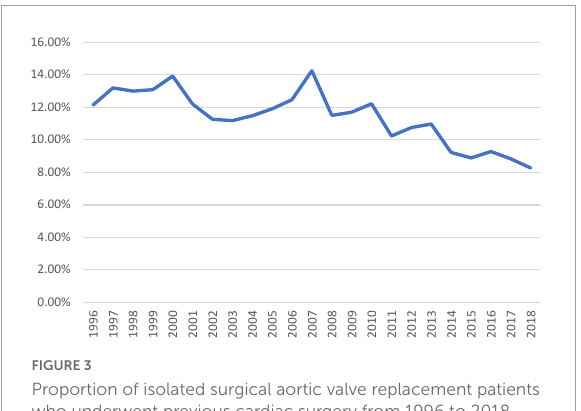
FIGURE3 Proportion of isolated surgical aortic valve replacement patients who underwent previous cardiac surgery from 1996 to